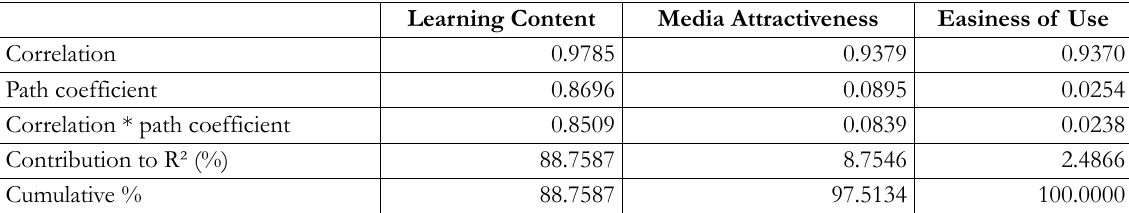
Table 7. Impact and contribution of the variables to Learning Outcome